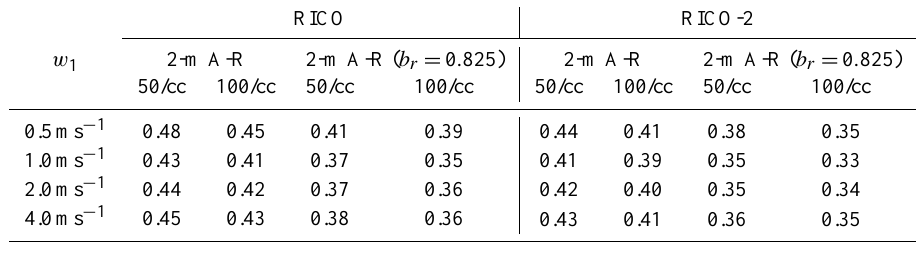
Table 5. Rain evaporation (kgm − 2 ; top), accretion (kgm − 2 ; middle) and surface precipitation (mm; bottom) accumulated over 2h from the 2-m A-R scheme, as a function of CCN, w 1 and T , and also from the 2-m A-R scheme with increased fallspeed parameter for rain, such that b r = 0 . 825. The evaporation and accretion terms are calculated by integrating the process rates with height at each timestep, and then integrating these values in time over a 2h period.